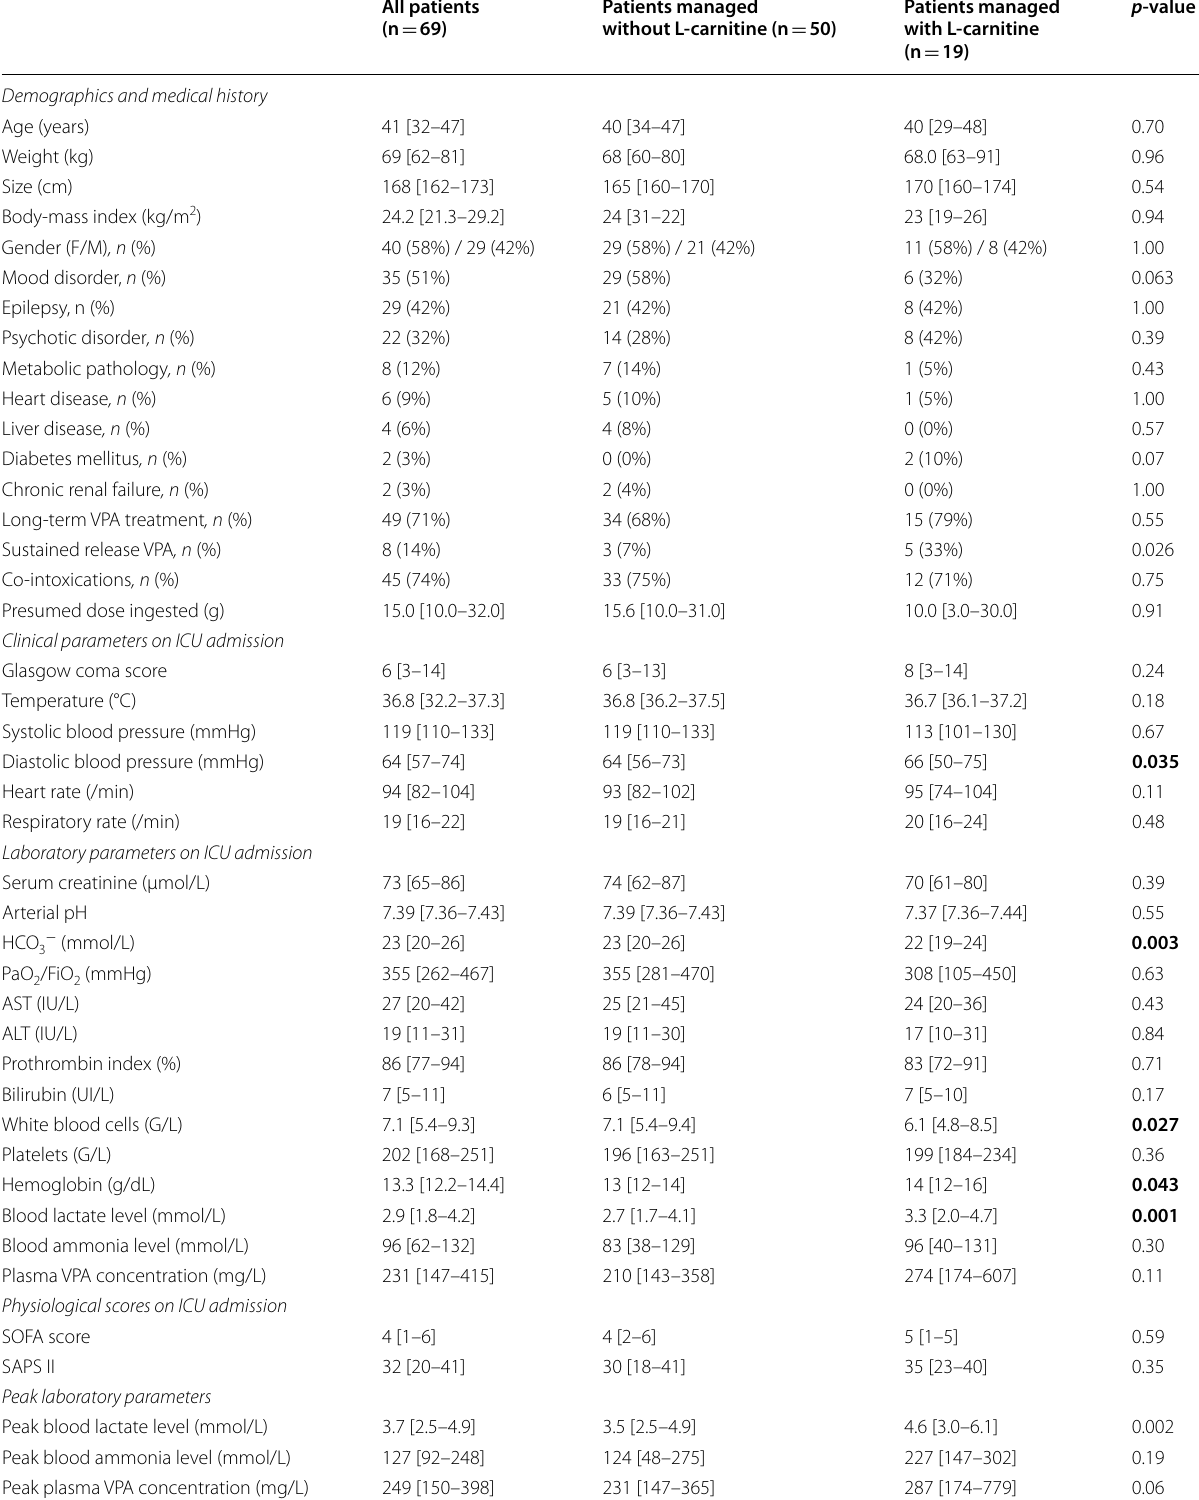
Table 1 Clinical and laboratory parameters in 69 valproic acid-poisoned patients on admission to the intensive care unit and univariate comparisons according to L-carnitine